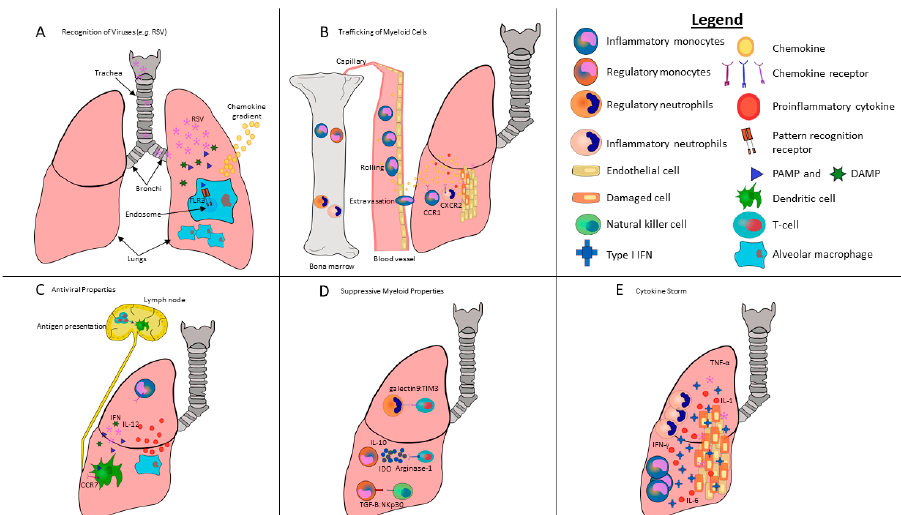
Figure 1. Schematic of myeloid cells highlighting their ability to respond to pulmonary viral infections via the initiation and modulation of anti-viral inflammatory activity. Lung-resident myeloid cells, such as alveolar macrophages, utilize a complex sensory system to integrate disturbances of pulmonary tissues by viruses such as respiratory syncytial virus (RSV) into the activation of local effector leukocytes. ( A ) RSV enters and infects the lungs. Viral pathogen-associated molecular patterns (PAMPs), such as double-stranded RNA or danger associated molecular patterns (DAMPs), are detected by pattern recognition receptors (PRRs) in or on sentinel cells in the lungs, such as TLR3 in the endosomes of lung-resident macrophages. TLR stimulation activates the NF- κ ß signaling cascade, resulting in the release of chemokines and inflammatory cytokines. A chemokine gradient forms between the lungs and bone marrow. ( B ) Homeostatic bone marrow tends to retain CXCR4 + neutrophils and monocytes through endogenous expression of high levels of CXCL12. However, the release of PAMPs, as well as the secretion of cytokines and chemokines as a consequence of pulmonary RSV infections, is sensed by cells in the bone marrow, which in turn allow recruitment of new neutrophils and monocytes from the bone marrow into the lungs. Specifically, G-CSF downregulates CXCR4 on neutrophils, triggering their release. Similarly, CCL2 is produced in the bone marrow by endothelial cells following TLR signaling in infected lungs, which is crucial for inflammatory monocyte release into the bloodstream. Once in the bloodstream, these cells sense disrupted endothelium from the viral infection, which triggers a complex adhesion cascade. Activated Ly6C hi inflammatory monocytes are recruited to the site of infection by a variety of chemokine receptors including CCR1, 5 and 6, as well as CXCR2 binding to their respective ligands. ( C ) Once at the site of infection, they differentiate into dendritic cells and macrophages that initiate an inflammatory cascade that includes copious amounts of inflammatory cytokines, in particular IL-12 and IFN- γ , which are potent inducers of Th1-biased immune responses. Once these dendritic cells and macrophages acquire viral antigens, they home to lymph nodes via chemokine receptors, including CCR7. Monocyte-derived dendritic cells that home to lymph nodes present viral antigens to naïve CD4 + and CD8 + T-cells that are required to kill infected cells. ( D ) The basic neutrophil function of clearing an inflamed area by removing killed pathogens and host cells contributes to reduced inflammation and wound debridement. Neutrophils are also capable of promoting tissue repair and increased angiogenesis. Further, monocytes can suppress lymphocytes in various clinical scenarios. In lungs, myeloid cells are able to inhibit pro-inflammatory tissue-resident leukocytes through direct cell-to-cell contact through galectin9/TIM3 and the effect of TGF- β on NKp30 in order to regulate T-cells and NK cells, respectively. Myeloid cells can also exert suppressive functions through secretion of soluble factors such as IL-10, arginase-1 and indoleamine 2,3-dioxygenase. ( E ) We speculate that disruption of the cellular sensing of type I IFN responses can result in excessive production of pro-inflammatory cytokines, including IFN- γ , IL-1, IL-6, and TNF- α , leading to a toxic cytokine storm. The fatal outcome of severe lung infections is shown to be correlated with the early persistent production of inflammatory cytokines and chemokines that recruit neutrophils and monocytes. While inflammatory cytokines and chemokines are essential for effective control of viral infections, they can also contribute to the severity of disease and tissue